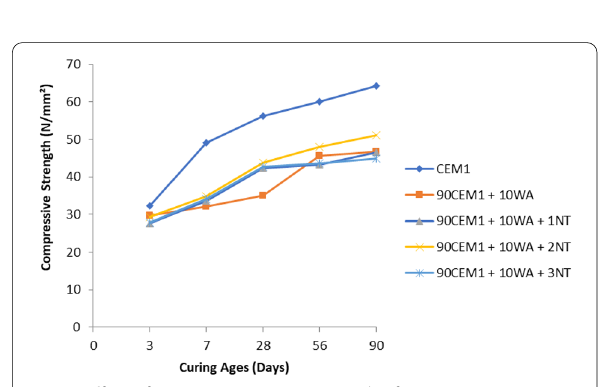
Fig. 5 Effect of NT on compressive strength of WA cement